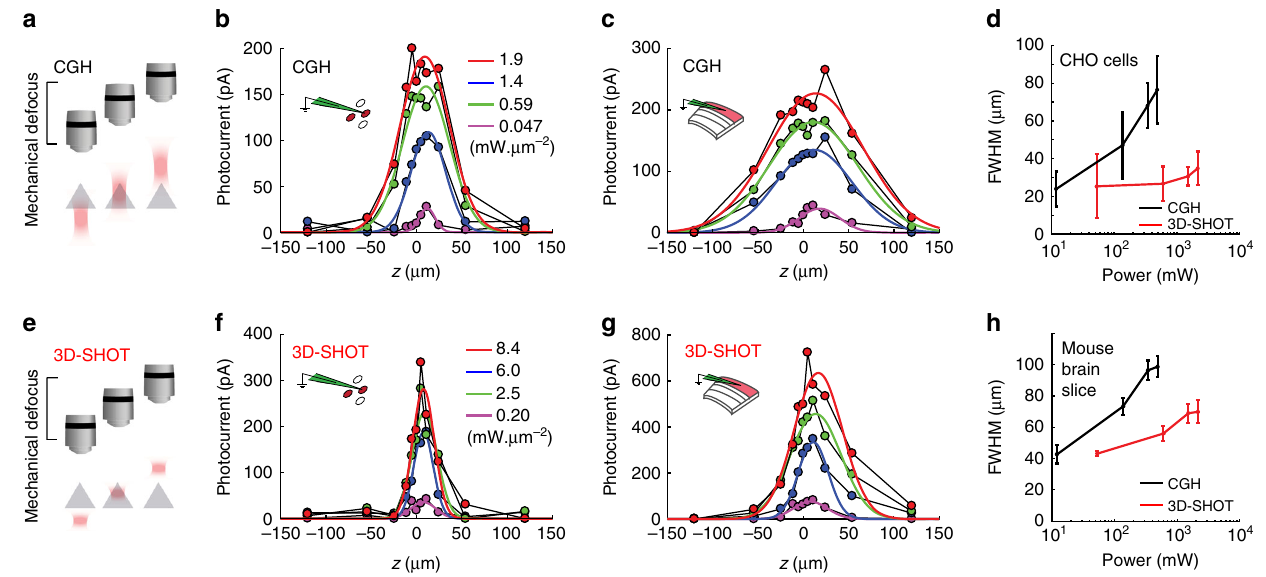
Fig. 3 3D-SHOT generates axially con fi ned photo-activation. a A photostimulation pattern generated with CGH was mechanically stepped along the optical z -axis and passed through a cell expressing opsin. Photocurrents were recorded in the whole-cell voltage clamp con fi guration. b − f The response pro fi le for CGH with a 10 µ m disk target and different power levels on CHO cells for CGH b or 3D-SHOT f ( n = 12 cells, data points are a representative example cell). d The FWHM of the characteristic response pro fi le for both methods at various power levels on CHO cells ( n = 12 cells, data represent mean ± s.e.m.). e As in a , but in mouse brain slices. c , g as in b , f , but in mouse brain slices ( n = 11 neuron, data points are a representative example neuron). h The FWHM of the characteristic response pro fi le for both methods at various power levels in mouse brain slices ( n = 11 neurons, data represent mean ±